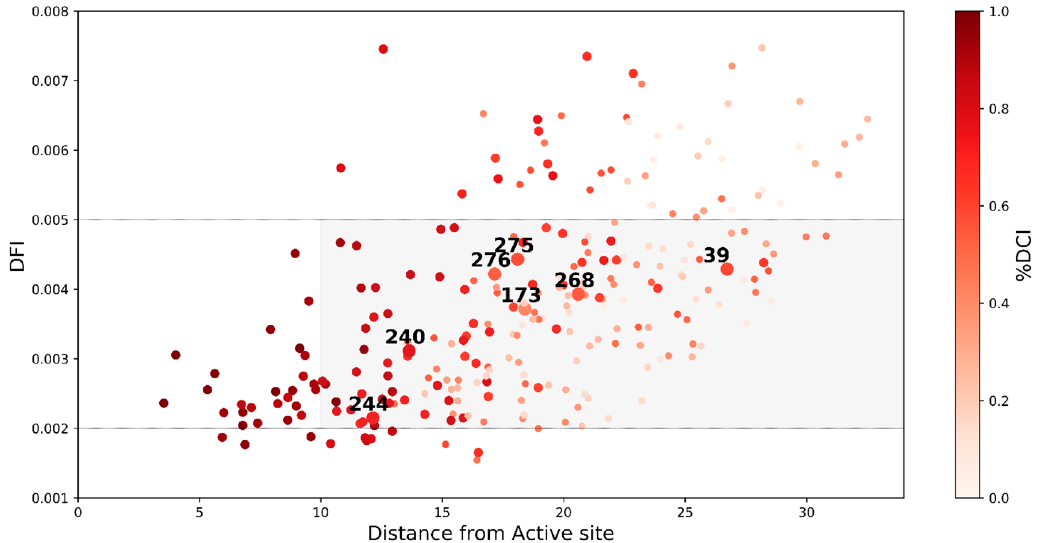
Figure 4. A distribution of flexibility of various residue locations in TEM-1 β -lactamase given by their DFI score (y-axis) with their distance from the catalytic region (x-axis). The residues are colored in accordance to the strength of their coupling with the active sites using their %DCI score with red being most coupled (%DCI = 1) to white without any coupling (%DCI = 0). We observed that a large number of the mutations analyzed in clinical isolates and laboratory evolution experiments of TEM-1 had a strong coupling (represented by bigger circles) regardless of being distal to the active sites. Moreover, these mutations, along with many other residue positions coupled to the active site, lay in a region of medium flexibility in the